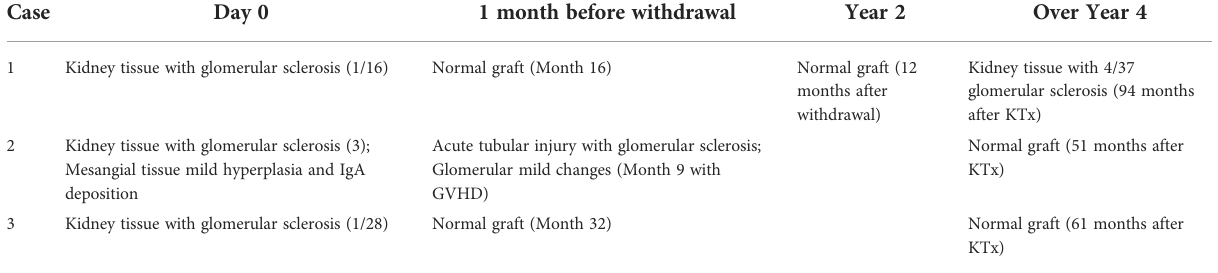
TABLE 3 Routine biopsy of kidney